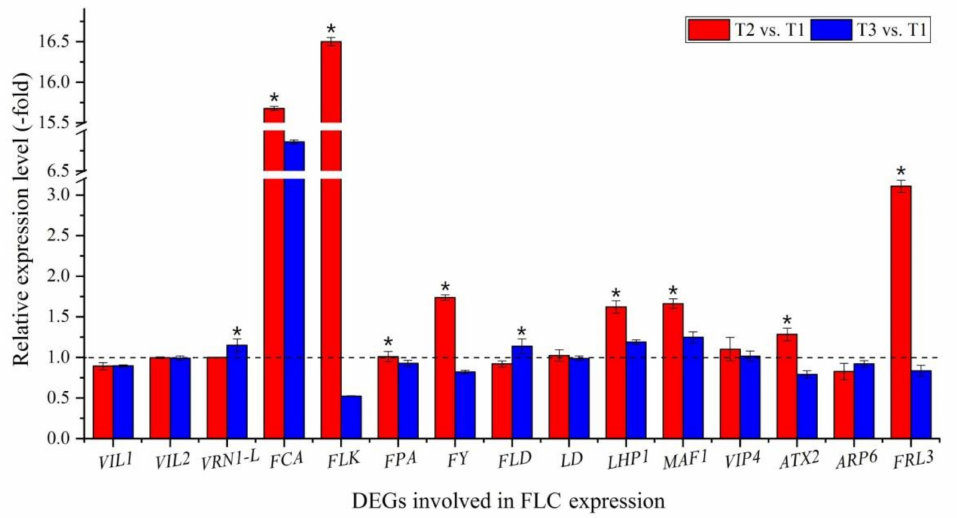
Figure 6. Expression levels of 15 genes involved in FLC expression at T2 vs. T1 and T3 vs. T1. Here and below, “*” represents a significant difference at the p < 0.05 level between T2 vs. T1 and T3 vs. T1 for the same